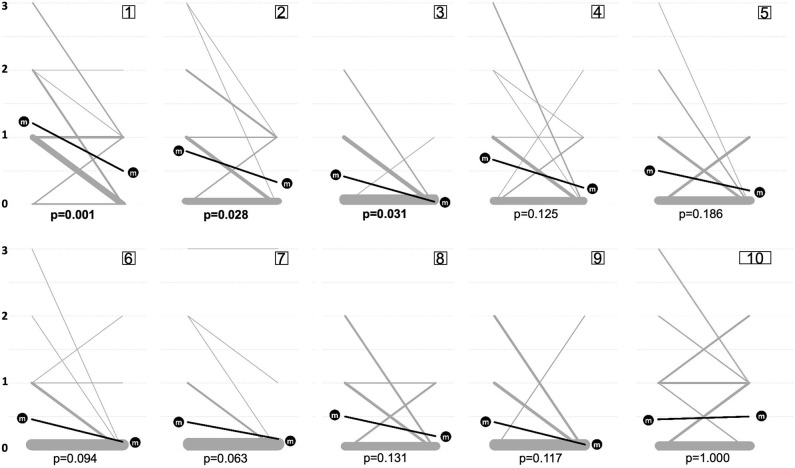
Evolution of DLQI items. Individual values of the 10 Dermatology Life Quality Index (DLQI) items for the time points prior to (left side) and after (right side) Psoralen-UV-A (PUVA) treatment. Numbers in square boxes on top of the panels represent item number of DLQI: item 1 (itching, aching, stinging), item 2 (embarrassment), item 3 (shopping, home), item 4 (affection on clothing), item 5 (social activities), item 6 (sports), item 7 (working, studying), item 8 (interpersonal problems), item 9 (sexual difficulties), and item 10 (treatment difficulties). Each item can be categorized with zero to three points. Items marked as not relevant were awarded with zero points. Thickness of gray lines is proportional to the number of patients and their DLQI evoluting in a certain way. Statistical comparison was performed by Wilcoxon signed-rank test, and respective p-values are shown underneath plots. Evolution of mean value (m) is shown by the black line and the black circles.